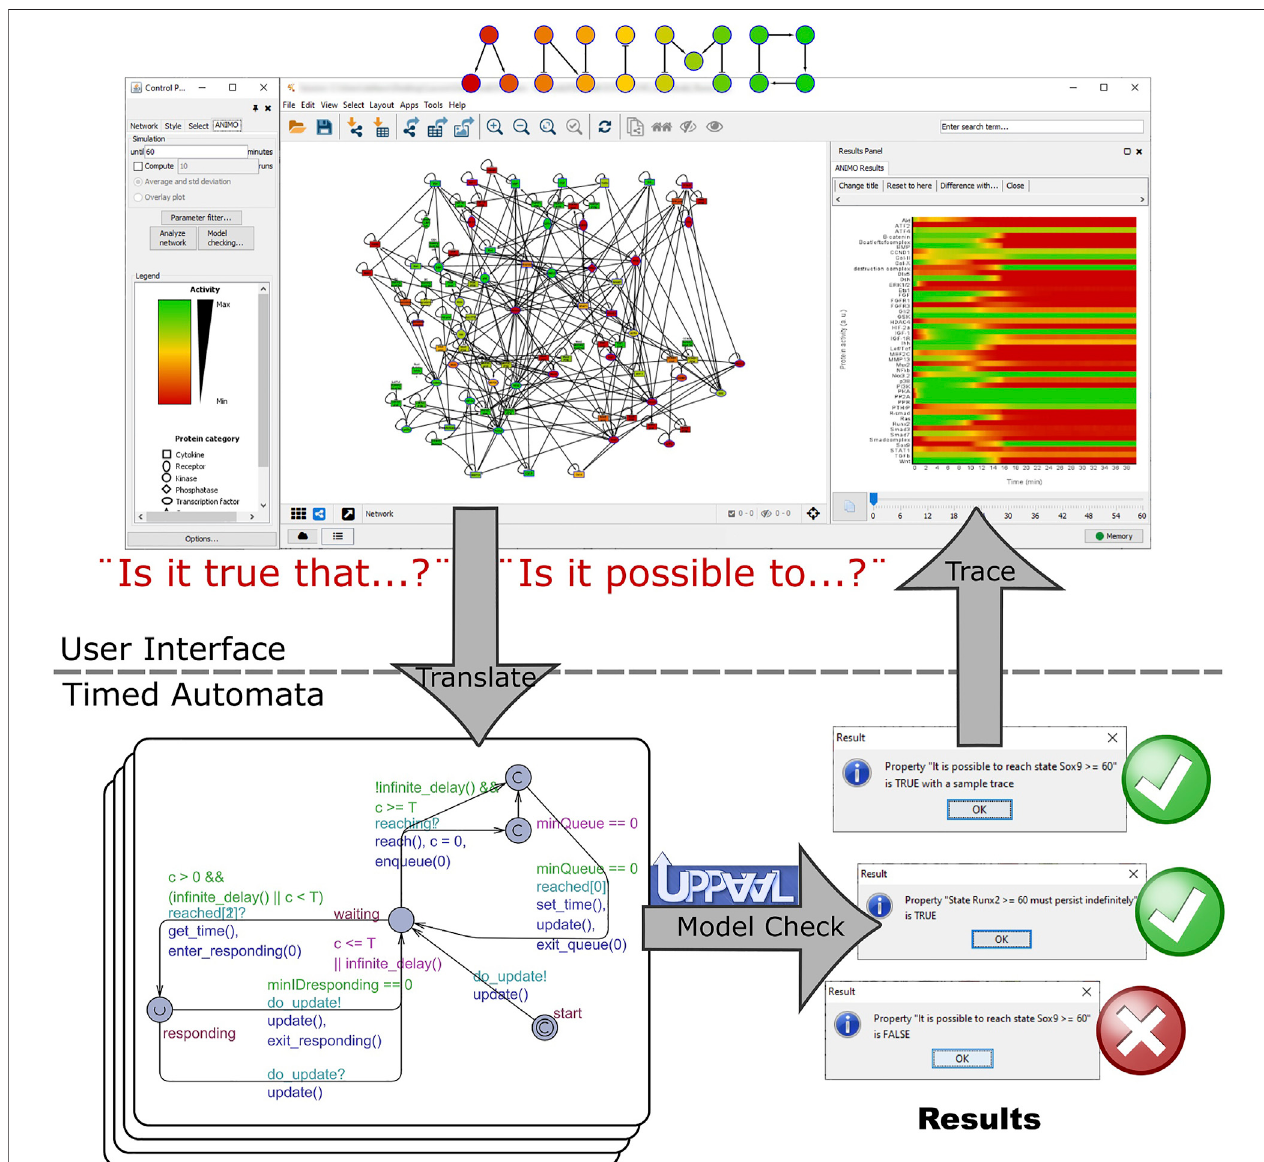
FIGURE 5| Work fl owof the model checking experiments. Model checking is used toensurethat the predicted behavior based on one simulation run isnot dueto errors or artifacts of the model. The tested conditions were: 1. BMP7+PTHRP, 2. ERK inhibition and addition IGF1, and 3. DLX5 activation with inhibition of PKA off. We used modelcheckingtoensurethatswitches occurinthemodelasexpected.Ifaformulaofthetype “ [initialstate] mustpersist inde fi nitely ” isfoundtobetrue, nofurther action is taken: we have the guarantee that the property is true in all possible future evolutions of the current con fi guration of the model. However, if the formula is foundtobefalse(orequivalently, theoppositeformula “ [oppositestate]canbereachedatleastonce ” isfoundtobetrue),anexampletraceisautomaticallyproducedby theUPPAALtool,analyzed byANIMO andrepresented asanactivity graphinCytoscape.Thistracerunsthroughonepossibleexecutionrunofthemodelandillustrates how it is possible that the tested property becomes false (resp.